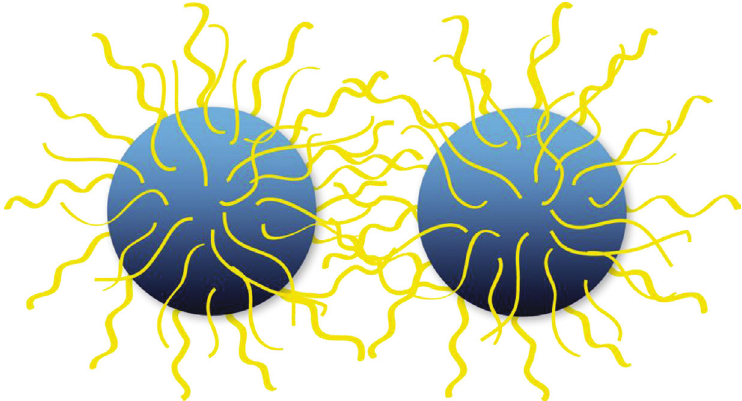
Figure 2: Steric stabilization of metallic AgNPs solution from surfactants found in